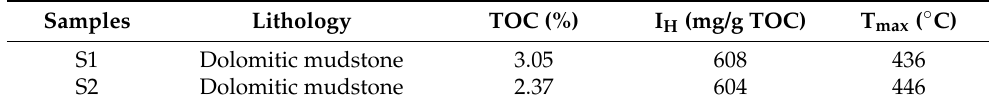
Table 1. Geochemical parameters of simulated hydrocarbon generation samples.